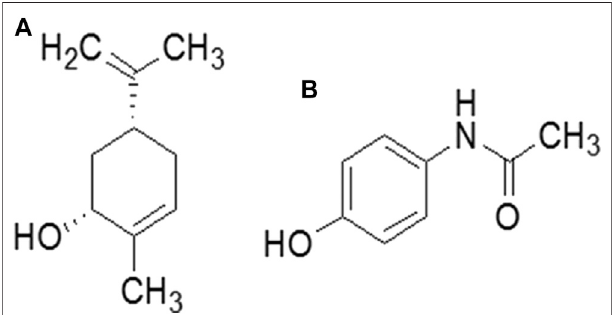
Figure 1 | Chemical structure of (A) carveol and (B)